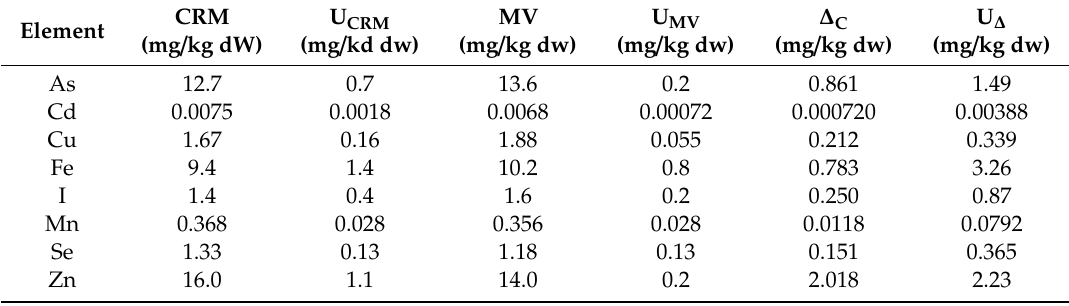
Table 1. Comparison between the measured and the certified values for the Certified Reference Material ERM ®